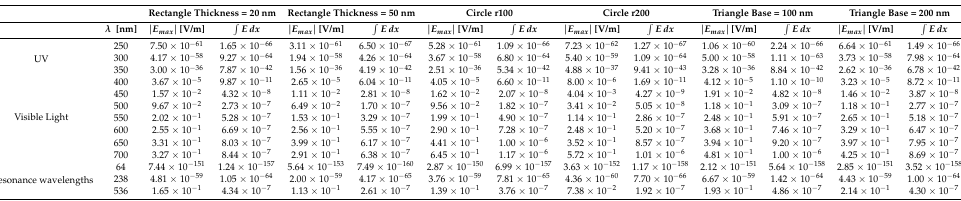
Table A9. Summary table of the results obtained for the gold nanostructures—Probe 3.